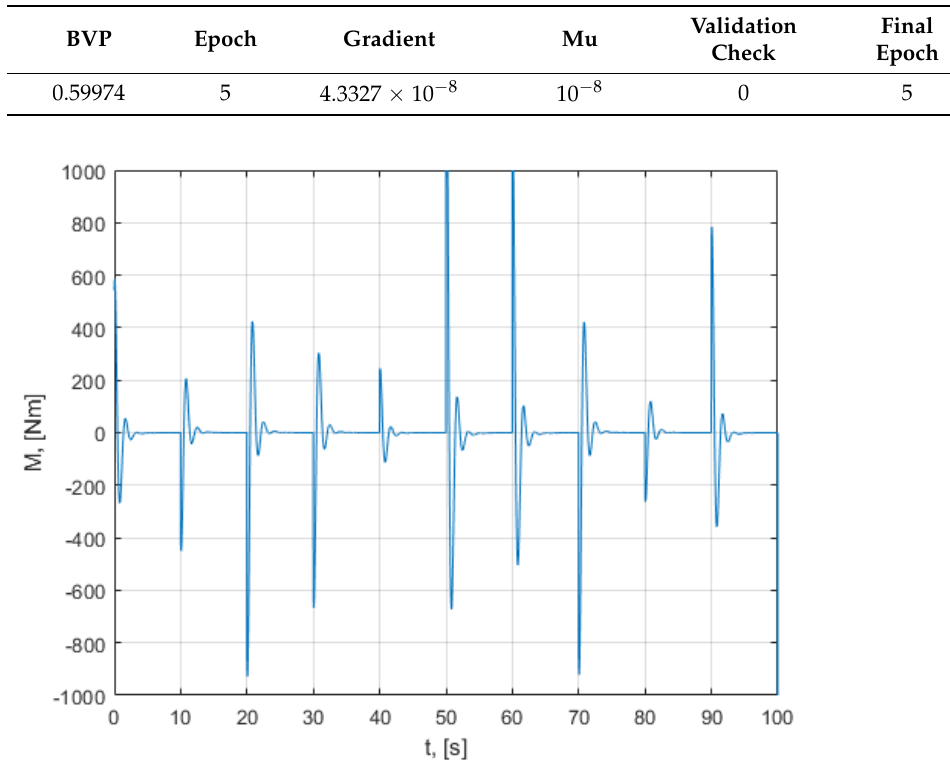
Figure 45. Neural network controller training regression. Table 10. Best validation performance and final state parameters.